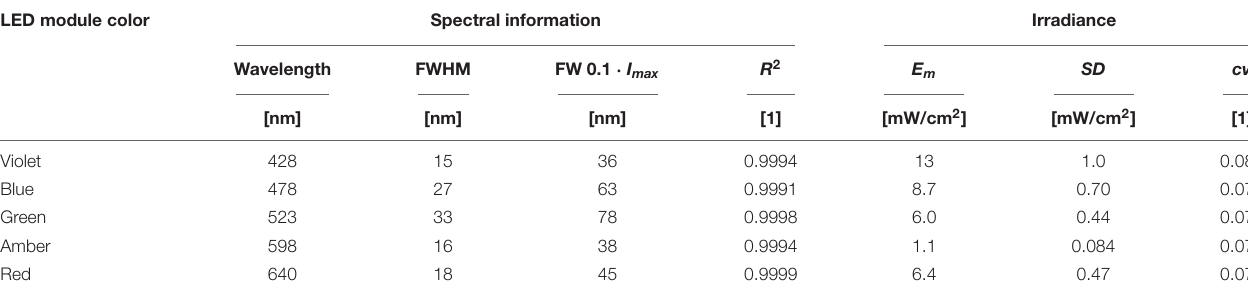
TABLE 1 | Optical characterization of the irradiation device. LED module color